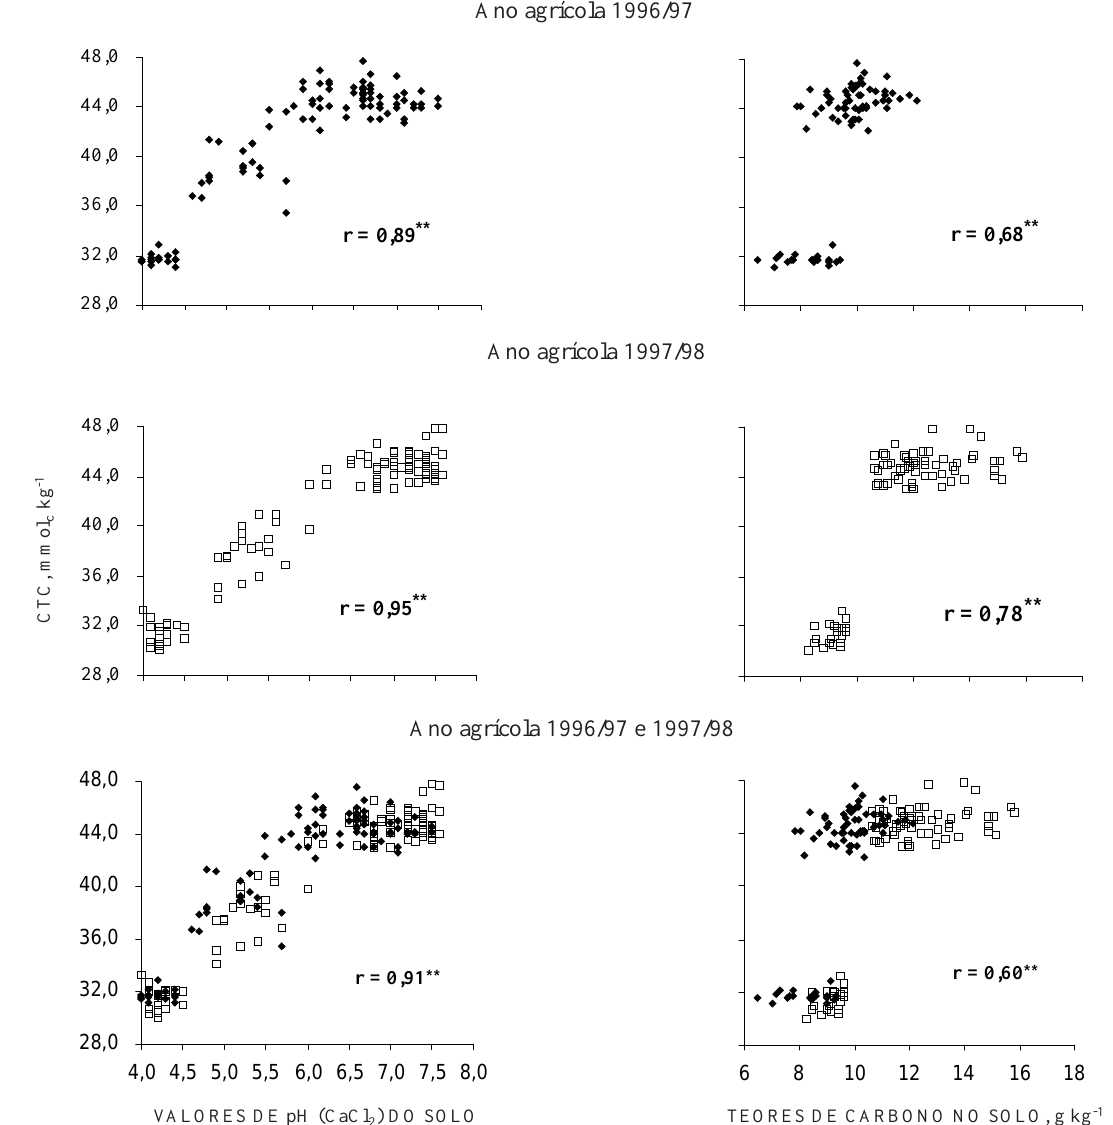
Figura 3. Relações entre CTC e pH, CTC e teores de carbono orgânico do solo, nos anos agrícolas de 1996/ 97( ¤¤ ¤¤¤ ) e 1997/98 ( ). ( ** Coeficientes de correlação significativos a P £££££ 0,01 pelo teste